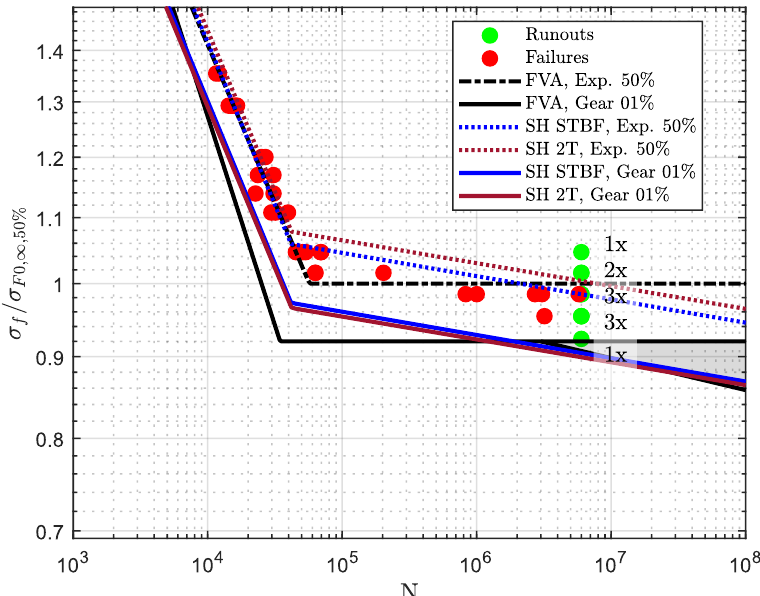
Figure 11. Comparison of the two estimation methods for exemplary campaign B from experimental FZG database [24,66].